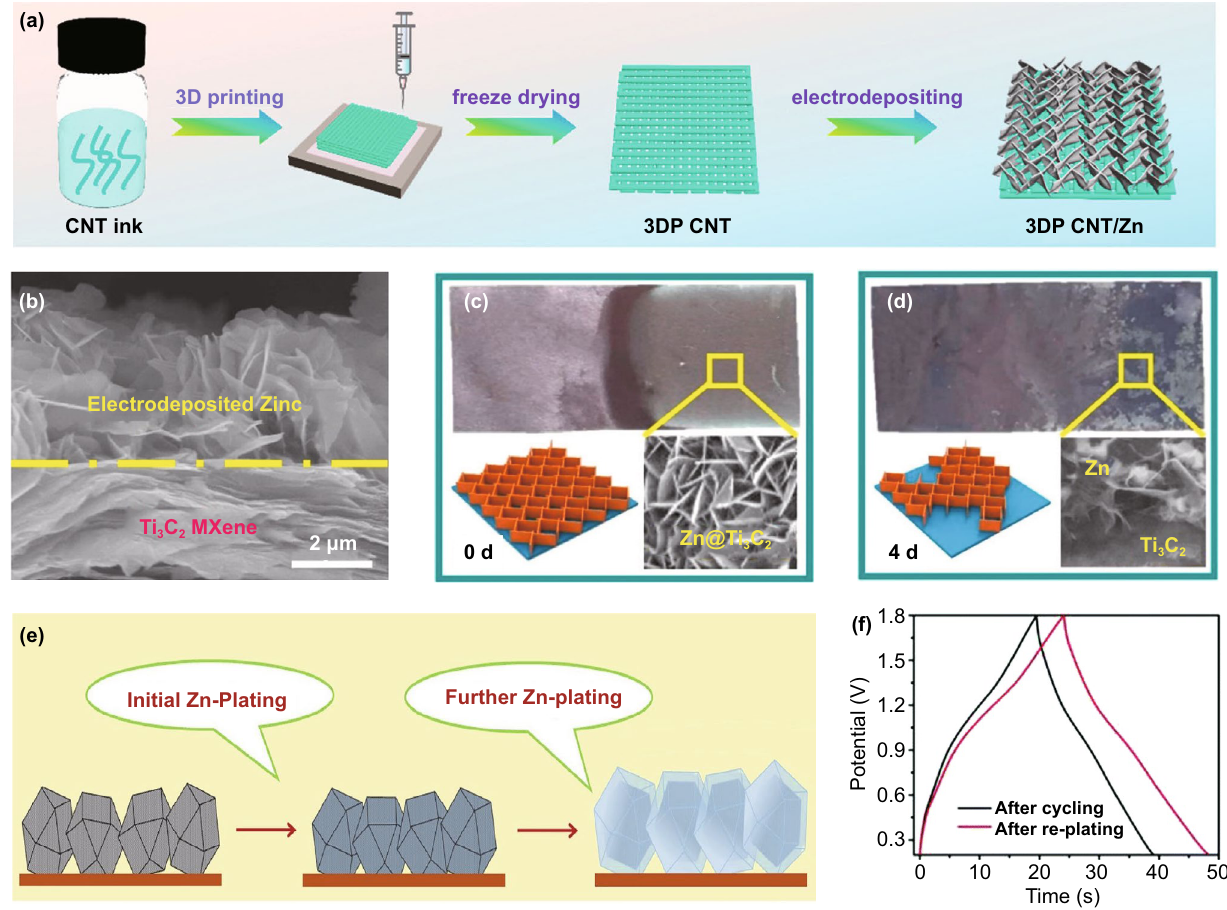
Fig. 3 a Schematic illustration displaying the manufacturing process of 3DP‑CNT/Zn anode. Reproduced with permission from Ref. [91]. Cop‑ yright 2021, American Chemical Society. b Cross‑section SEM image of Zn@Ti 3 C 2 anode. c , d Digital, SEM and schematic images of Zn@ Ti 3 C 2 anode after different time in PBS at 85 °C. Reproduced with permission Ref. [96] Copyright 2019, American Chemical Society. e Sche‑ matic illustration of the two‑steps Zn plating on ZIF‑8. Reproduced with permission from Ref. [90]. Copyright 2019, Elsevier. f Galvanostatic charge/discharge (GCD) curves of the devices after cycling and re‑plating. Reproduced with permission from Ref. [97]. Copyright 2018, Royal Society of